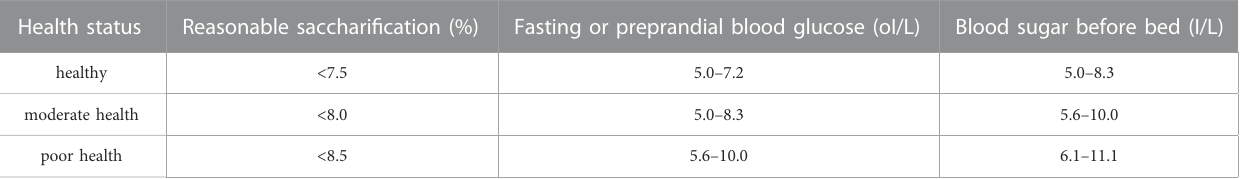
TABLE 1 Glycemic control criteria for type 2 diabetes in the